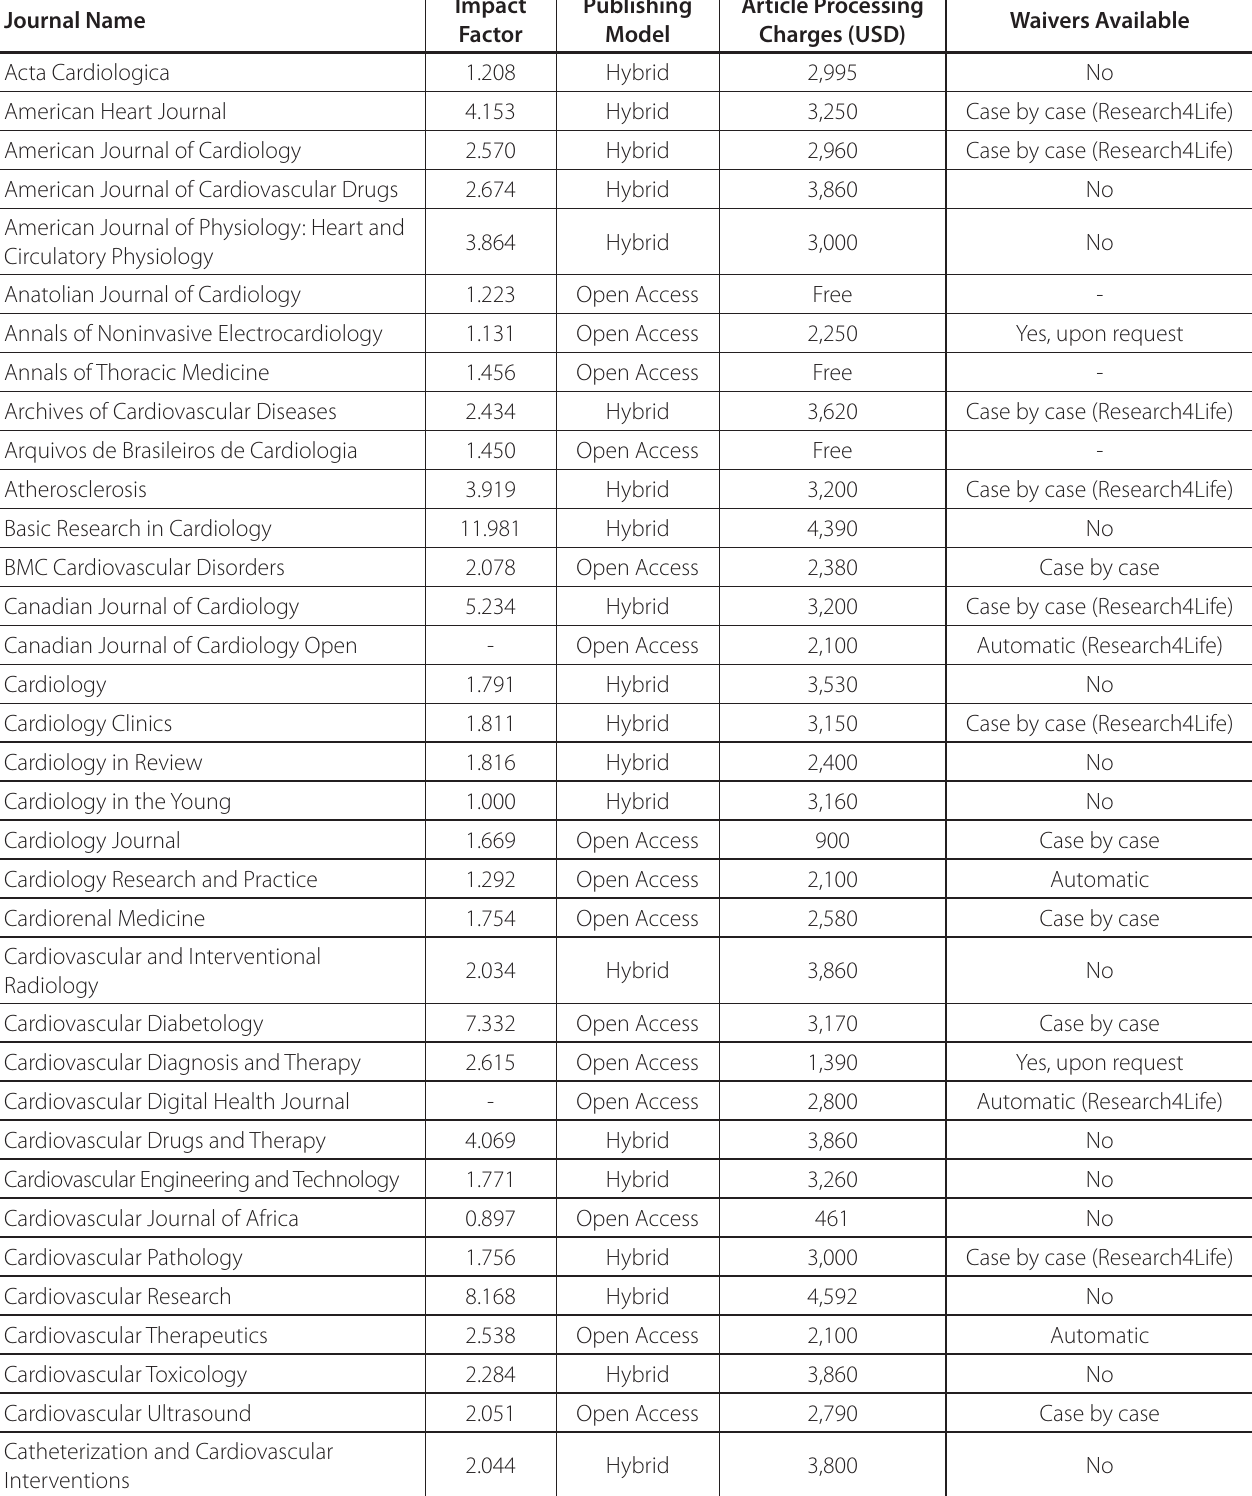
Supplemental Table 1 . Publishing models and article processing charges for cardiology journals indexed in InCites Journal Citation